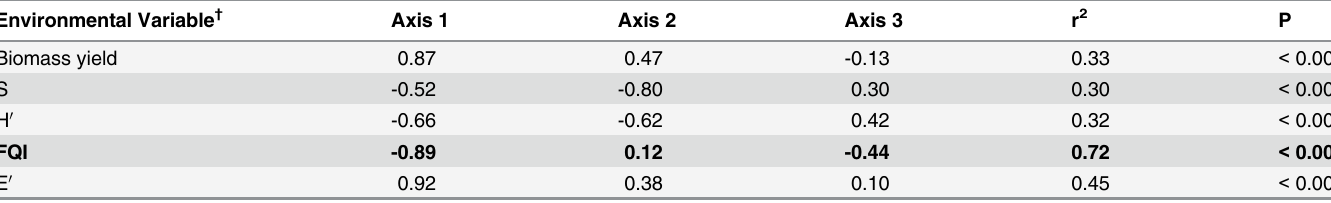
Bold indicates environmental variables with r 2 > 0.50, whose vectors are shown on nonmetric multidimensional scaling plots.